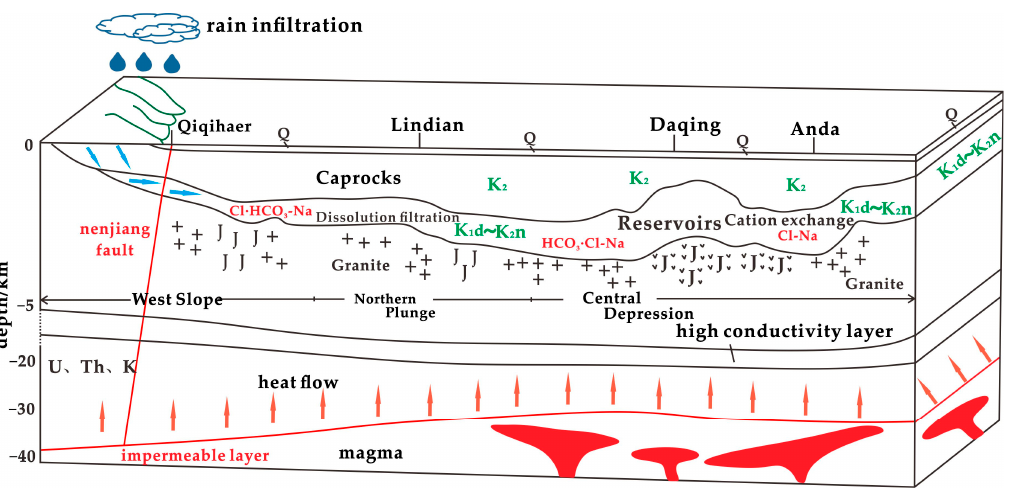
Figure 9. Conceptual model of the genetic mechanisms of the geothermal system in the study